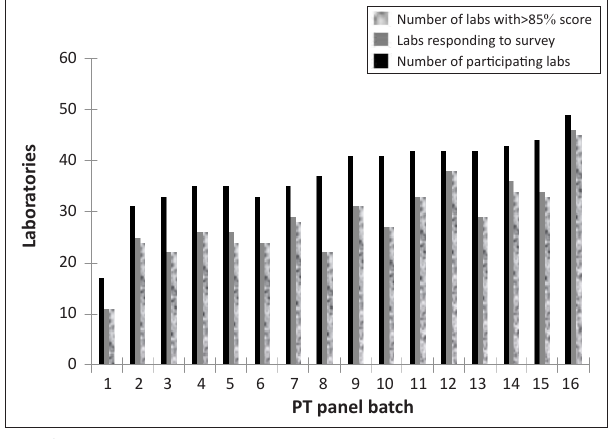
FIGURE 3: Summary of EQA results for the survey period during 2002–2010.